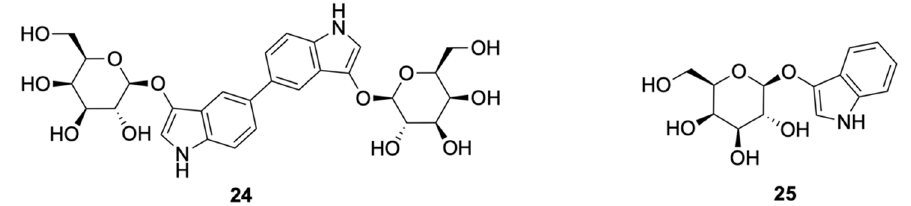
Figure 5. Structures of polymeric indoxyl substrate 24 and 3-indoxyl- β - d -galactopyranoside 25 .